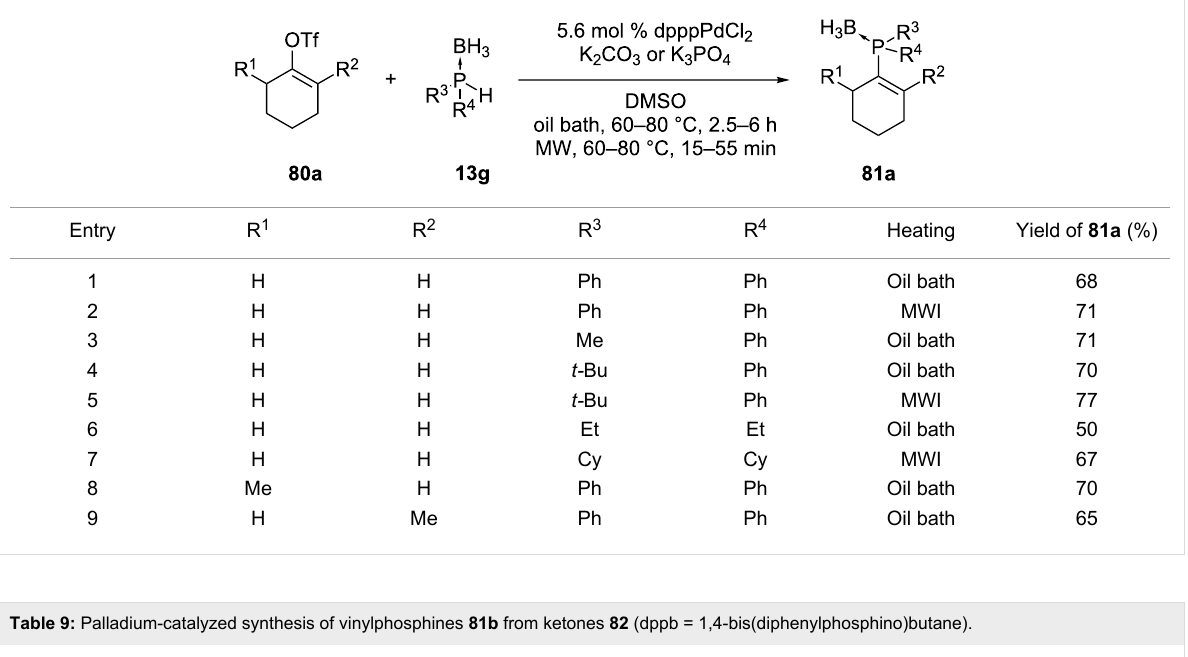
Table 8: Palladium-catalyzed C–P coupling between cyclic vinyl triflates and phosphine boranes (dppp = 1,3-bis(diphenylphosphino)propane).